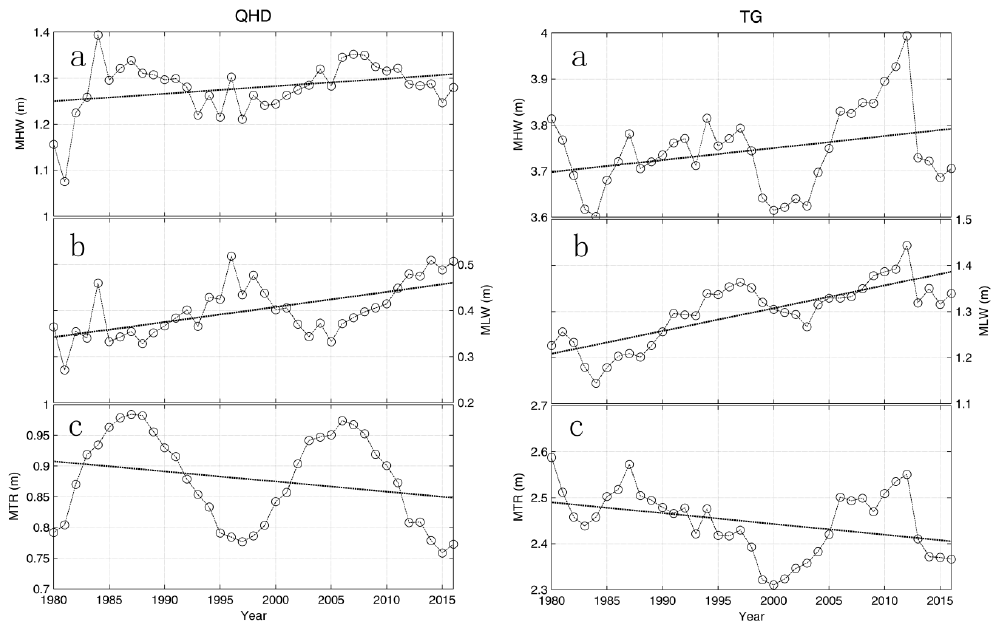
Figure 4. Three indices at four tide gauges: annual mean high water (MHW) ( a ); annual mean low water (MLW) ( b ); and annual mean tide range (MTR) ( c ). The dotted lines show the linear trends. Table 2. The linear trends of the MHW, MLW and MTR (cm/year), and correlations between the tide and mean sea level (C).